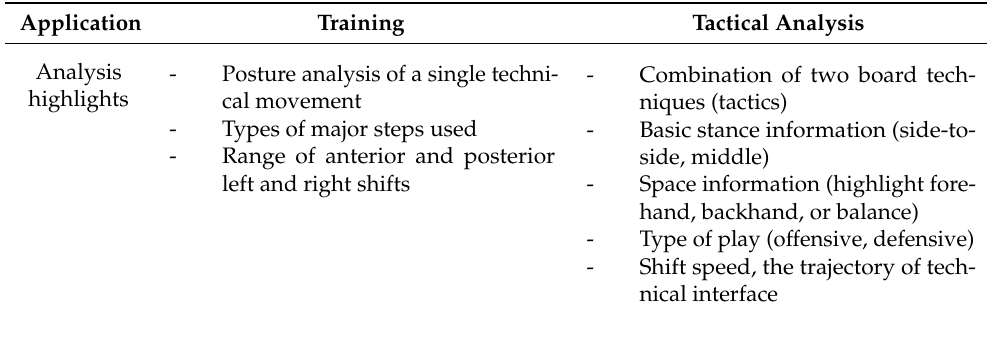
Table 2. The main analysis points of the AI application in the training and tactical analysis of the game of table tennis.